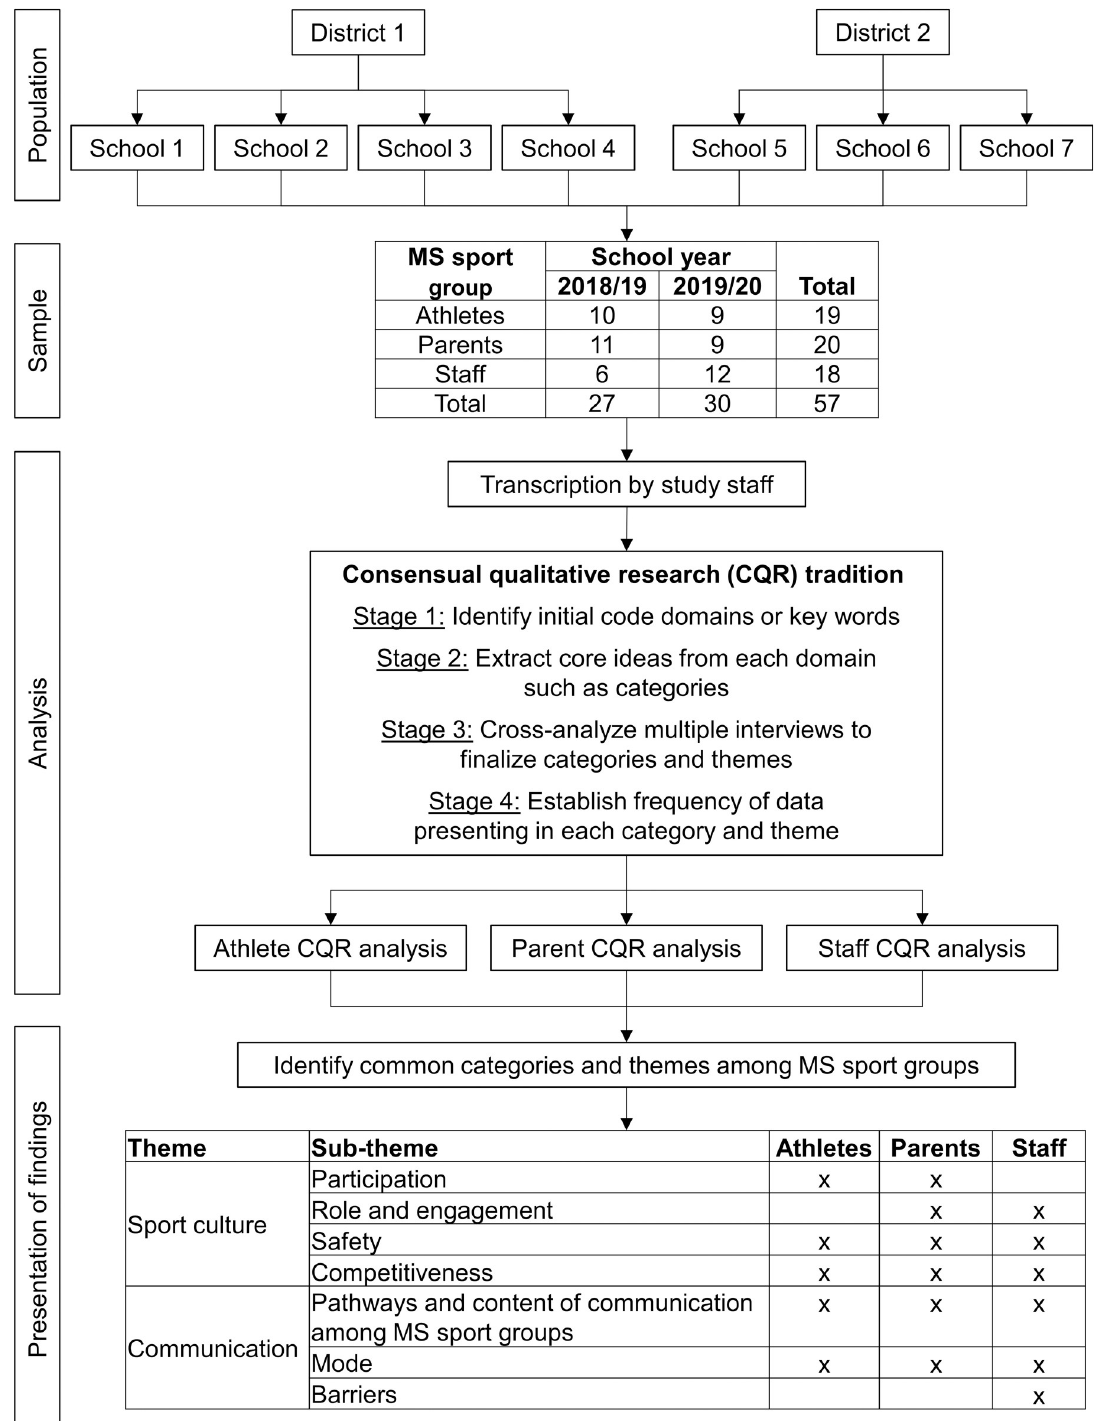
Fig 1. Study recruitment, analysis, and themes/categories